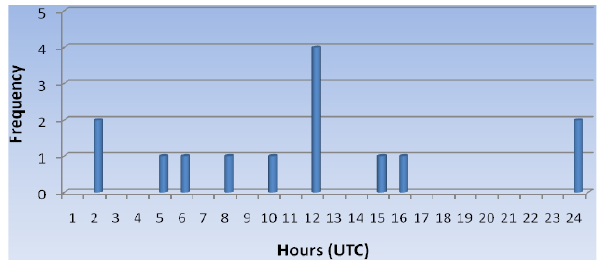
Figure 3 . Hourly variability of tornado activity in Greece within the 20 th century. Fig. 3. Hourly variability of tornado activity in Greece within the 20th